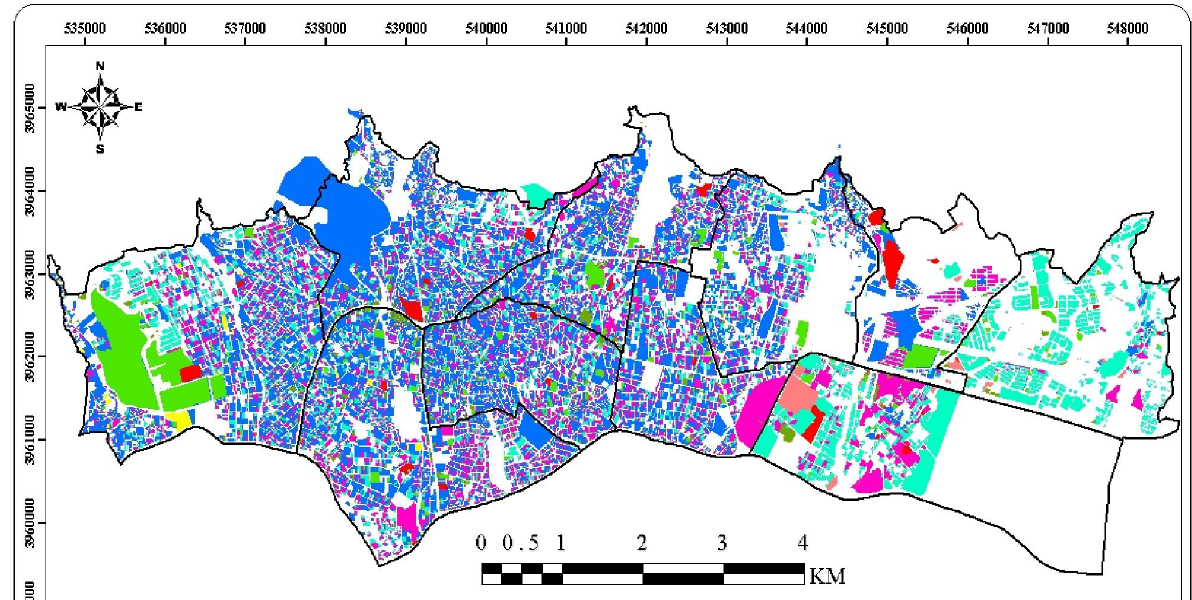
Fig. 2. The municipal district used for case study divided into 10 sub-regional